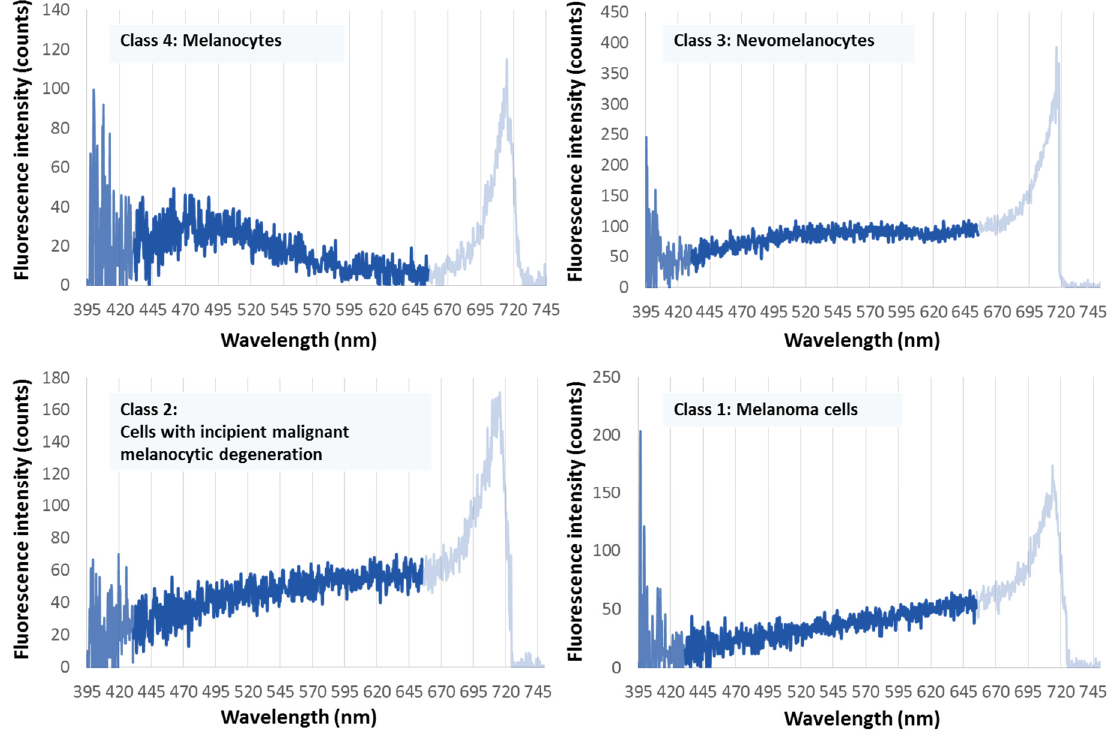
Figure 2. The four characteristic melanin fluorescence spectra of pigmented skin cells in the spectral range between 430 nm and 650 nm. Upper left: melanocytes; upper right: nevomelanocytes; lower left: dysplastic nevomelanocytes; lower right: melanoma cells. The fluorescence is excited by stepwise two-photon absorption with 800 nm/2 ns pulses (principle of dermatofluoroscopy). (The intensity above 650 nm results from another non-linear process not considered here. In any case, it is ensured that its intensity is zero below 650 nm.)